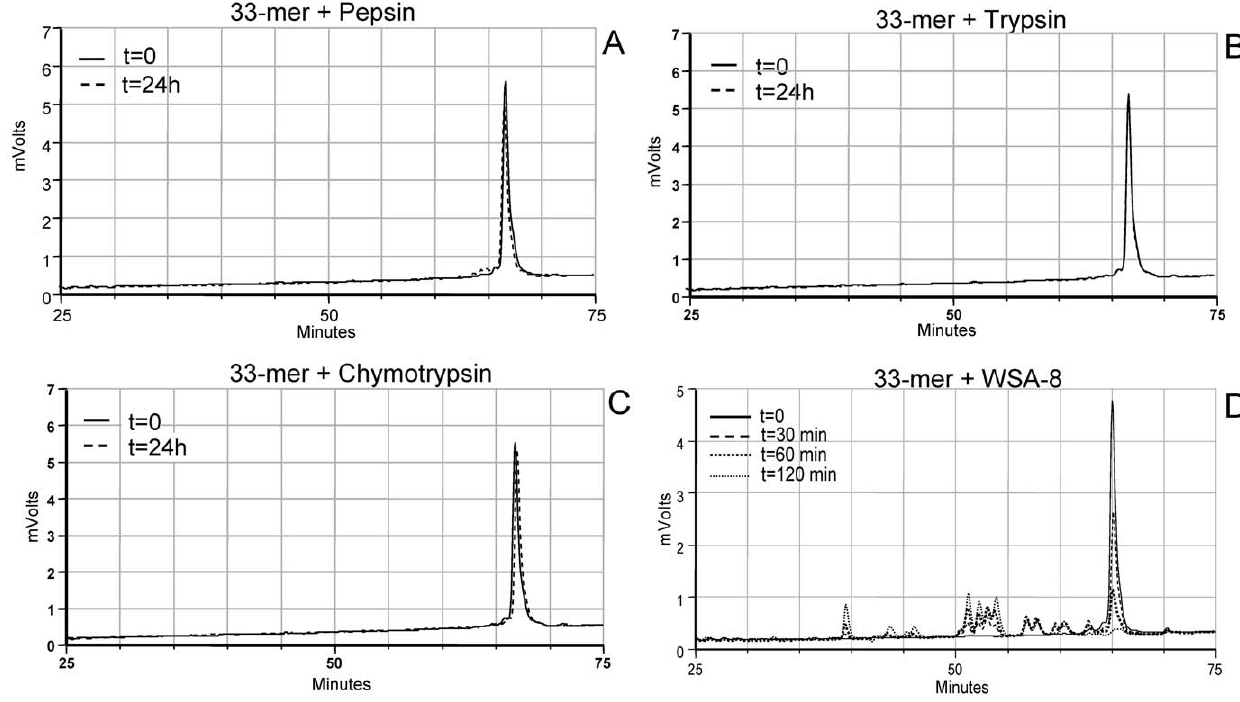
Figure 4. Degradation of the 33-mer by mammalian enzymes and by enzymes associated with R.aeria . The 33-mer peptide was incubated with pepsin (A), trypsin (B), chymotrypsin (C) (each 1 m g/ml) sampled at t=0 and t=24 h or in a suspension of WSA-8 ( R. aeria ) cells (D; OD 620 1.2) sampled at t=0, 30 min, 60 min and 120 min. Degradation of the 33-mer in incubation aliquots was monitored by RP-HPLC.